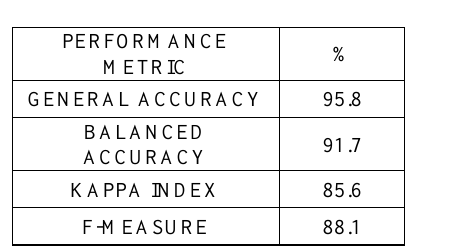
Table 2. Confusion matrix.